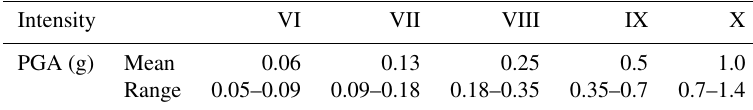
Table 7. The recommended intensity–PGA relations in China (GB/T 17742-1980/2008).